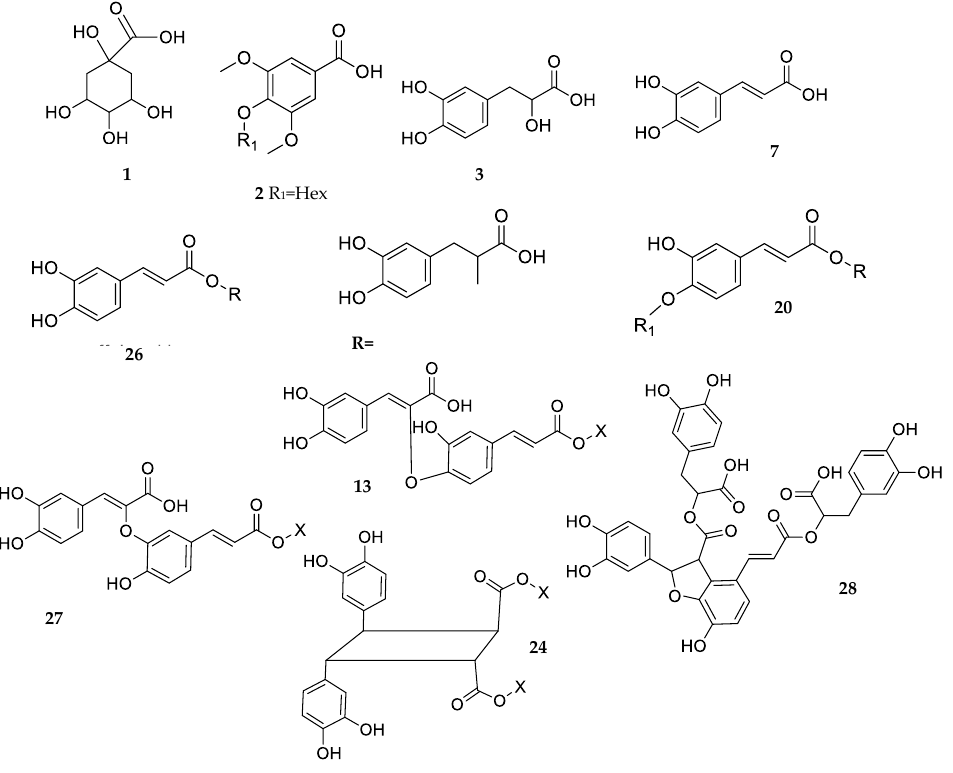
Figure 1. Chemical structures of fatty acids and phenolic compounds identified in Thymus zygis , Thymus pulegioides , and Thymus fragrantissimus . Numbers in the figure correspond to the UHPLC-DAD-ESI-MS n peaks of Figure